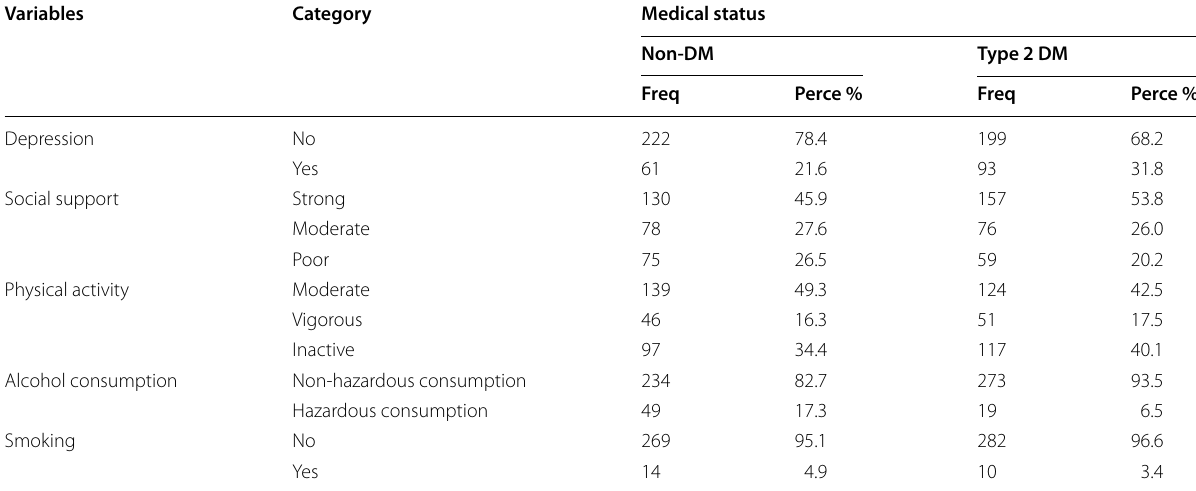
Table 3 Psychosocial and behavioral characteristics among individuals with type 2 DM and non-DM individuals Bahir dar city, Ethiopia, 2021. (575)